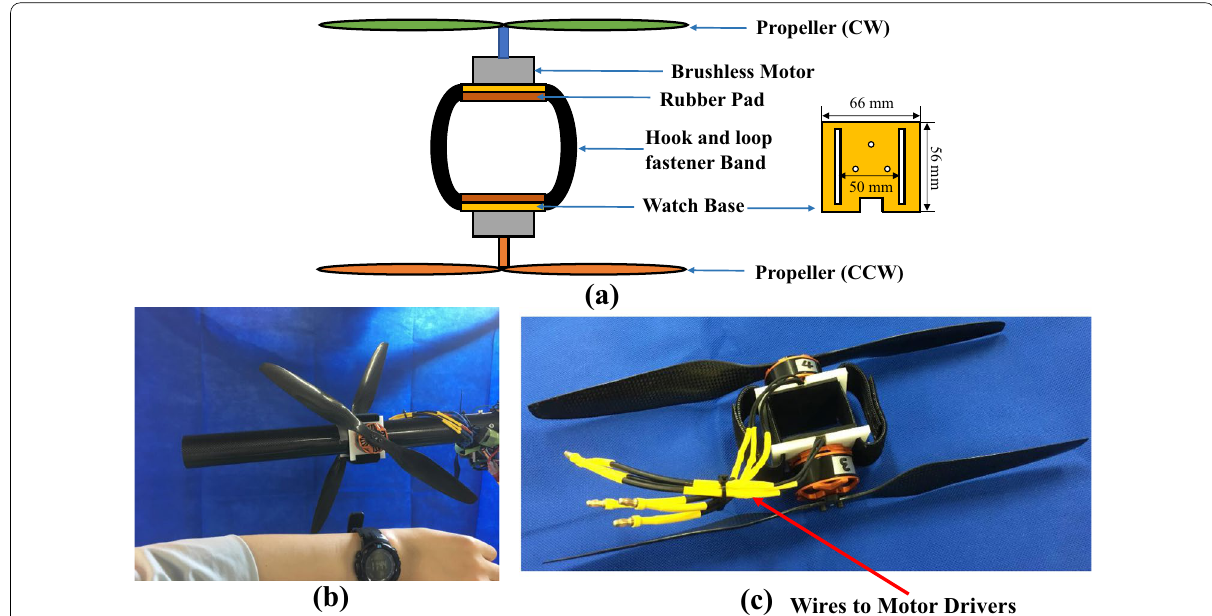
Fig. 1 a Mechanical design of a flying watch (one propeller rotates in clockwise (CW) direction and the other propeller rotates in counterclockwise (CCW) direction). b Flying watch attached to a robotic arm link. A wrist watch is also included in the photo to illustrate the structure similarity between a flying watch and a wrist watch. c Flying watch module before attaching to robot links. This figure is adapted from [14]